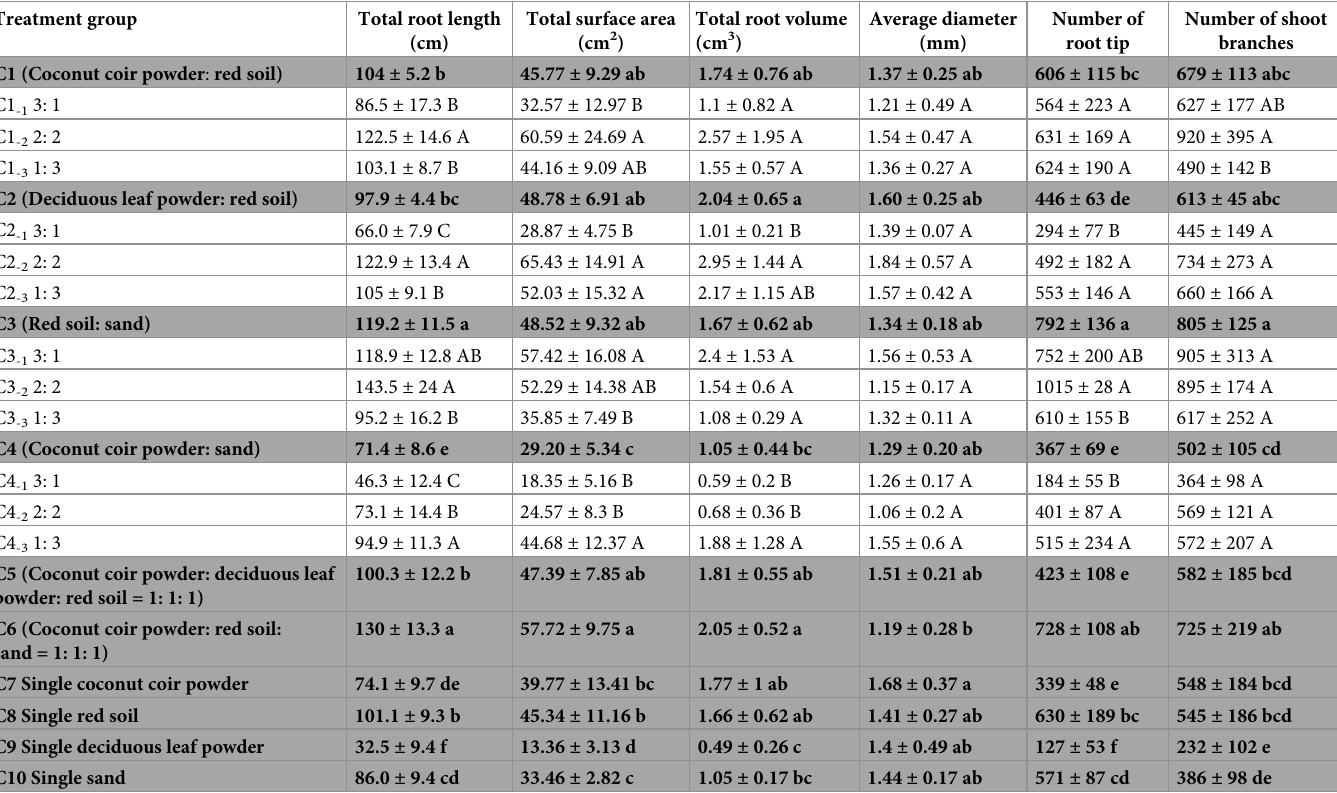
Table 2. Effect of substrate combinations and proportions on the development of D . odorifera root systems. Different lowercase letters in the same column indicate the significant difference among different substrate combinations (P < 0.05). Different uppercase letters in the same column indicate the significant difference among the same substrate with different proportions (P <